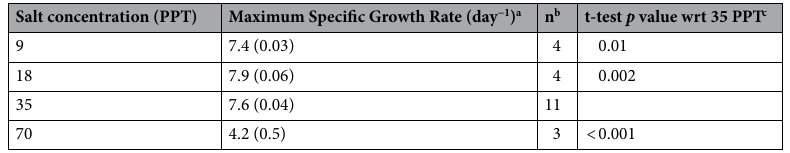
Table 4. Maximum specific growth rates of Picochlorum celeri in constant light (900 μmol m −2 s −1 PAR) at 33 °C in dilute-culture medium as a function of the concentration of Instant Ocean sea salts. a Standard error is given in the brackets. b n represents the number of replicates for each condition. c gives the t-test p value for each concentration with respect to growth rates at 35